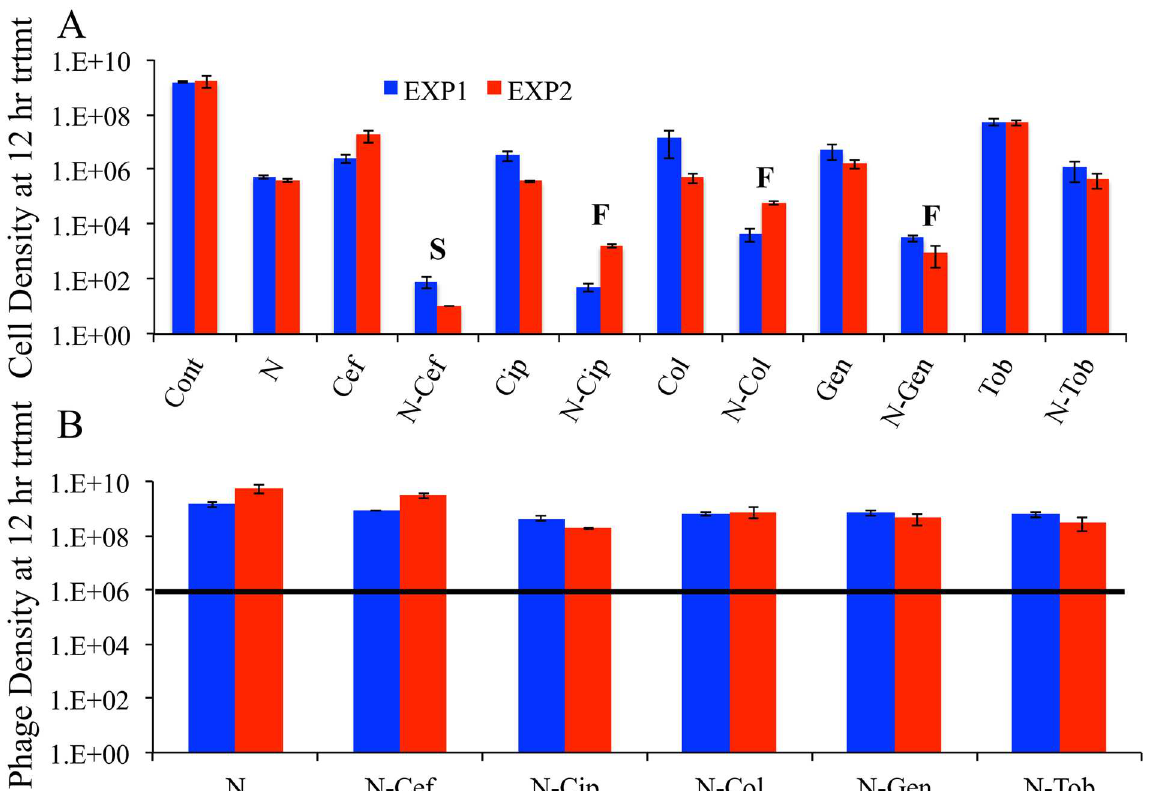
Fig 6. Treatment of biofilm grown on epithelial cells. Treatment of 8 hours old biofilm populationof P . aeruginosa PA14 on humanepithelialcells treated with a mixture of NP1 and NP3 phage (N) and 1X MIC concentrations of ceftazidime,ciprofloxacin, colistin, gentamicinand tobramycin. A- Viablecell densitiesof Pseudomonas estimated in two independentexperiments (red, blue) at 12 hours of exposureto the treatments. ‘S’ indicatesstatistical support for synergy and ‘F’ for facilitation. B- Densitiesof phage in two independentexperimentssampled12 hours after treatment. The bold black line in B is the density of the mixture of NP1 and NP3 introduced to the biofilm. Mean ± standard error for 3 replicates. Raw data of these experiments can be found in (S4 Excel File).